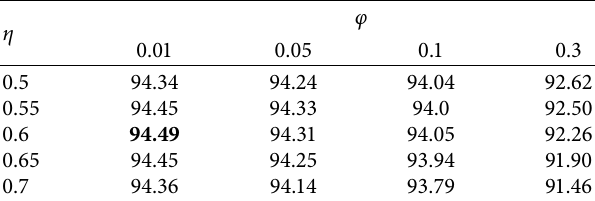
Table 1: Abnormal behavior evaluation for diferent weights of prediction model on Ped2 dataset (diferent combinations of η and φ